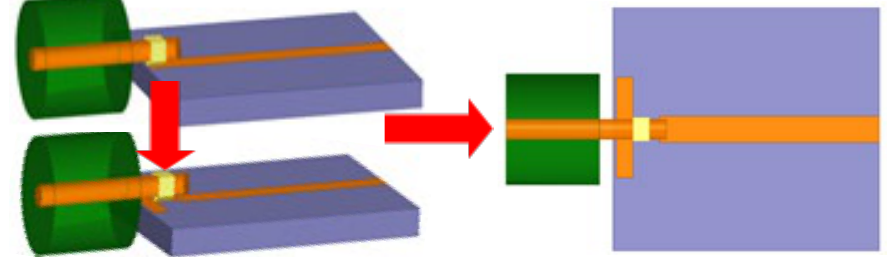
( b ) Figure 6. S-parameter of the above structures. ( a ) S11 of the above structures; ( b ) S21 of the above structures. Based on the above, the stress characteristics and electromagnetic matching charac- teristics of the four structures are summarized and analyzed, as shown in Table 3 and Figure 6. Core wire winding soldering, gold-ribbon lap bonding, and gold-ribbon wrap bonding all have better temperature change and mechanical adaptability. The electrical performance of wrap bonding is similar to that of direct soldering. The microwave per- formance of the wrap bonding can be designed further. Since the gold ribbon in the wrap bonding increases the inductive parasitic parameters, the capacitive matching de-